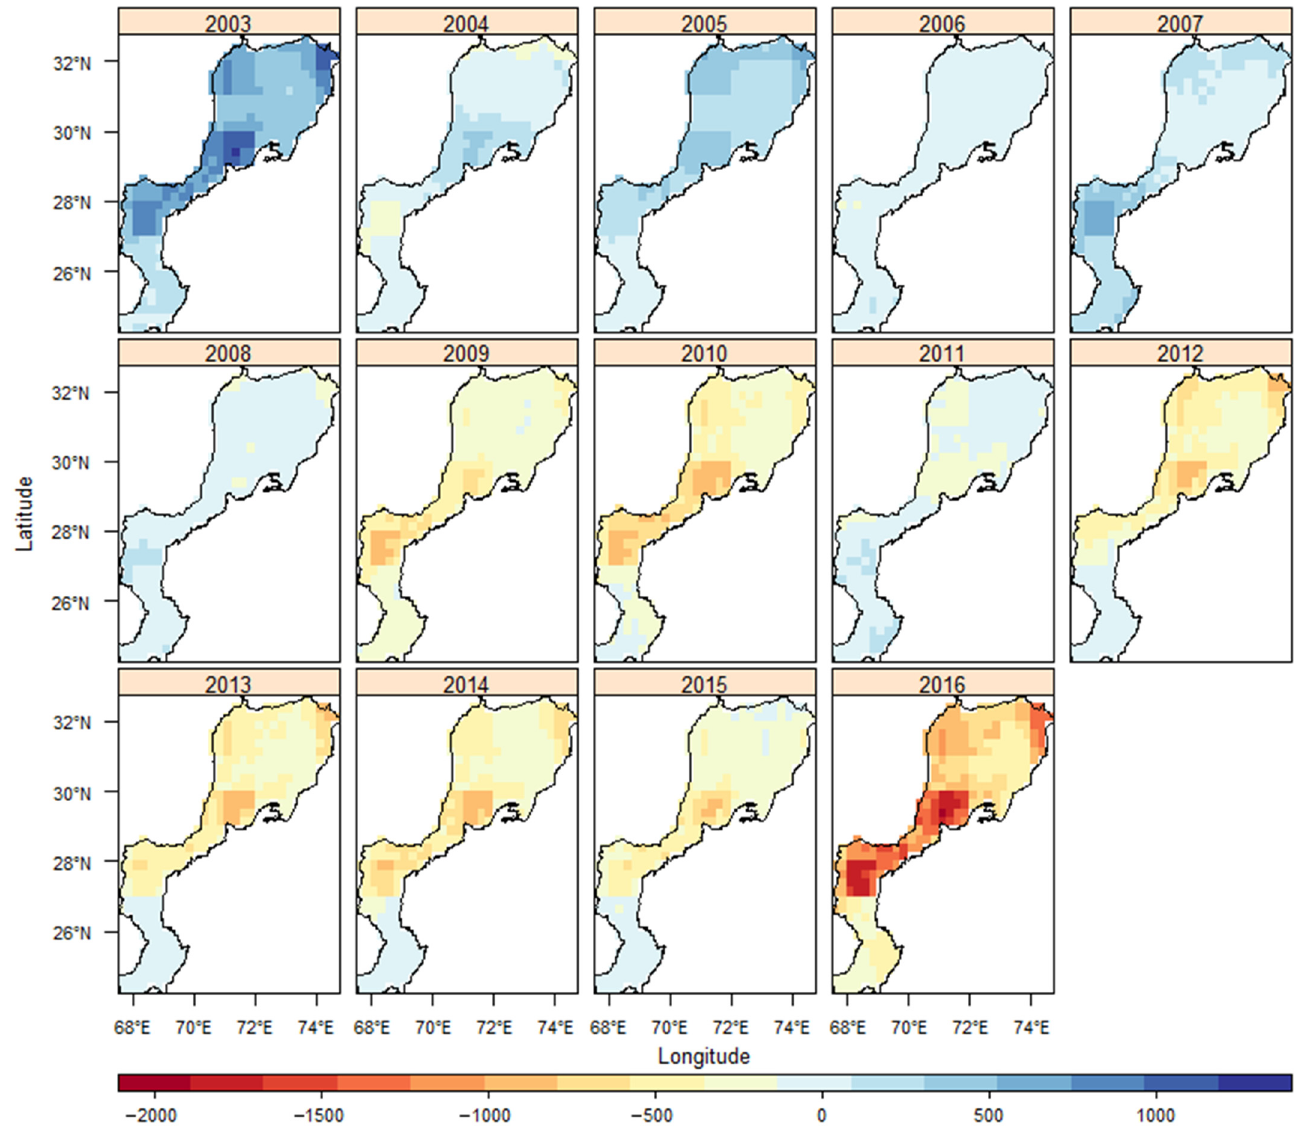
Figure 10. Spatial distribution of TWS anomaly (mm) on a yearly basis.